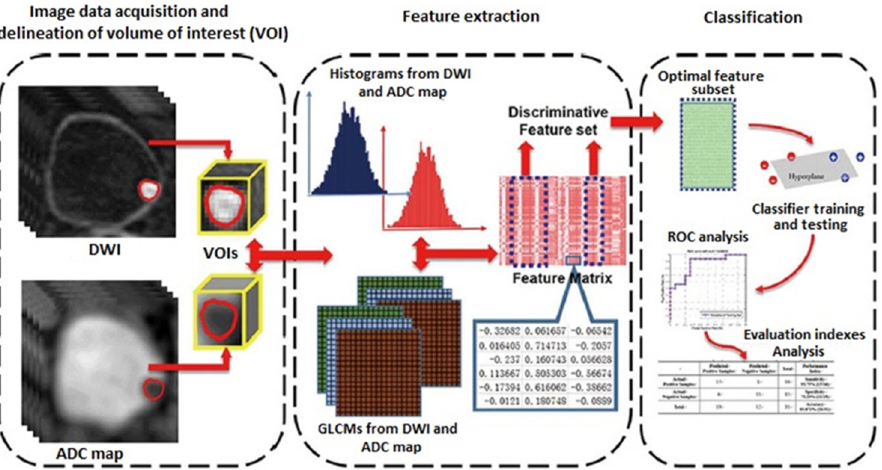
Figure 2. Radiomics strategy for bladder cancer staging (DWI: diffusion-weighted imaging; ADC: apparent diffusion coefficient; GLCM: gray-level co-occurrence matrix; ROC: receiver operating characteristics curve.